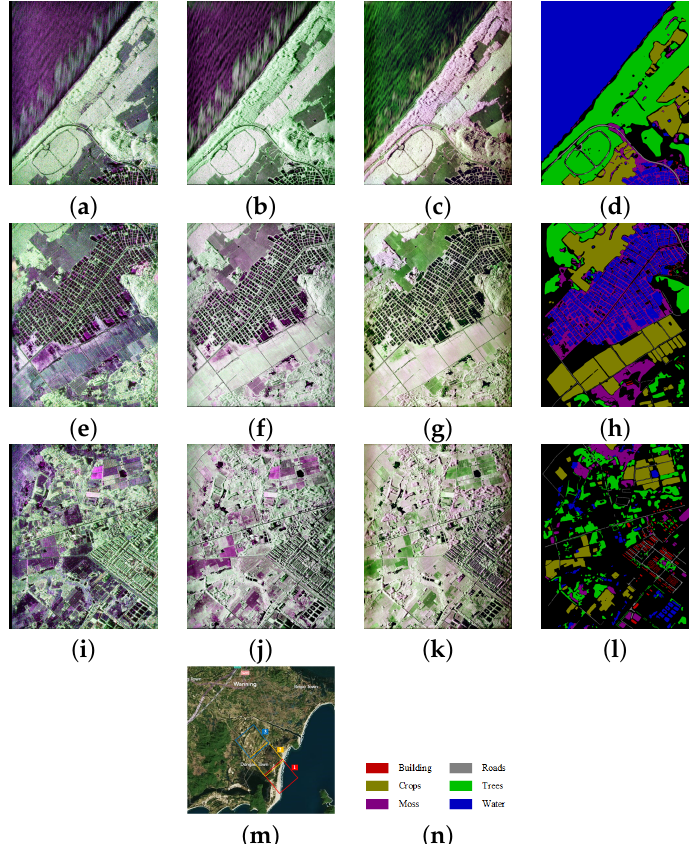
Figure 6. The Hainan dataset, including three images. ( a , e , i ) The pseudo Pauli images of L-band. ( b , f , j ) The pseudo Pauli images of C-band. ( c , g , k ) The pseudo Pauli images of the Ka-band. ( d , h , l ) The ground truth images. ( m ) The geographic location of the three images of the dataset (marked with three frames). The researching area is centered at ( 18 ◦ 43 (cid:48) 37 (cid:48)(cid:48) N,110 ◦ 24 (cid:48) 28 (cid:48)(cid:48) E ) . ( n ) The colormap of the six